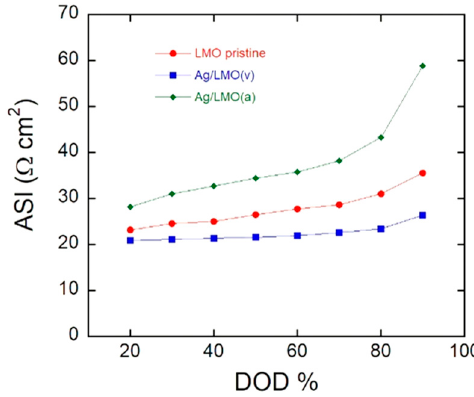
Figure 15. Area specific impedance (ASI) of parent LMO and Ag-coated LiMn 2 O 4 as a function of depth of discharge (DOD).